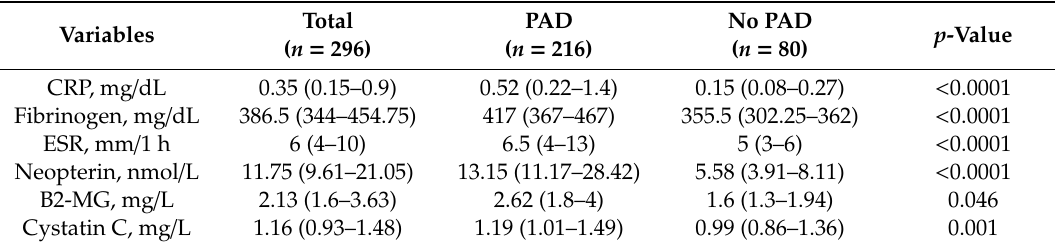
Table 2. Biomarker comparison of PAD and control groups *.